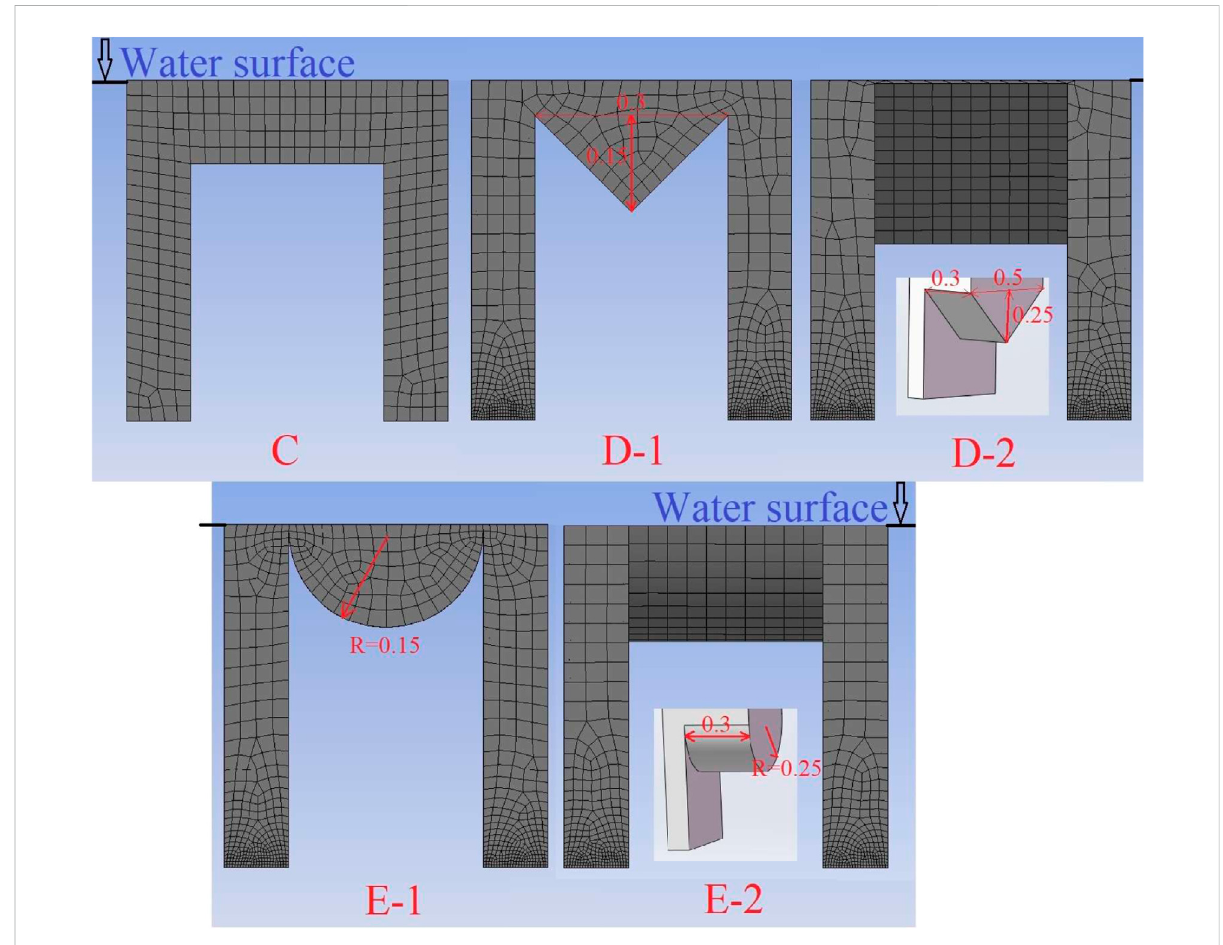
FIGURE 14 Dual-chamber OWC models with different bottom shapes of the buoyancy module.